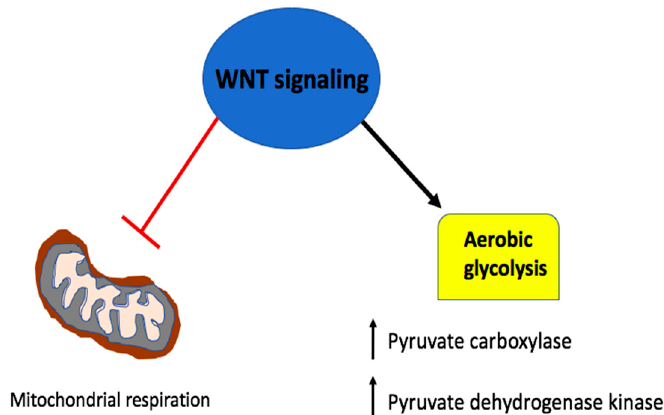
Figure 2. Wnt signaling in the metabolic reprogramming of cancer cells. The Wnt pathway upregulates aerobic glycolysis in part through its control of pyruvate carboxylase and pyruvate dehydrogenase kinase, enzymes that shift the metabolic requirement away from the mitochondrial oxidative phosphorylation (OXPHOS).